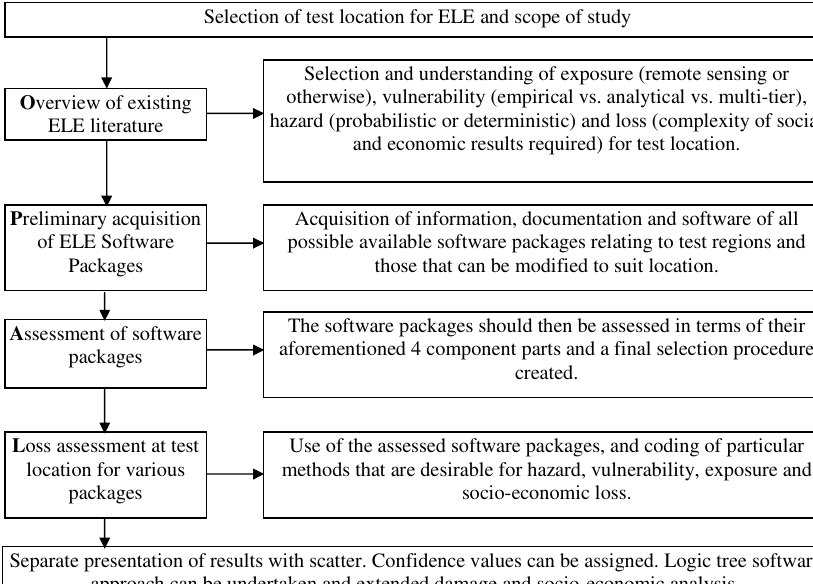
Figure 1. Flowchart of the generalised OPAL Procedure 2 Fig. 1. Flowchart of the generalised OPAL